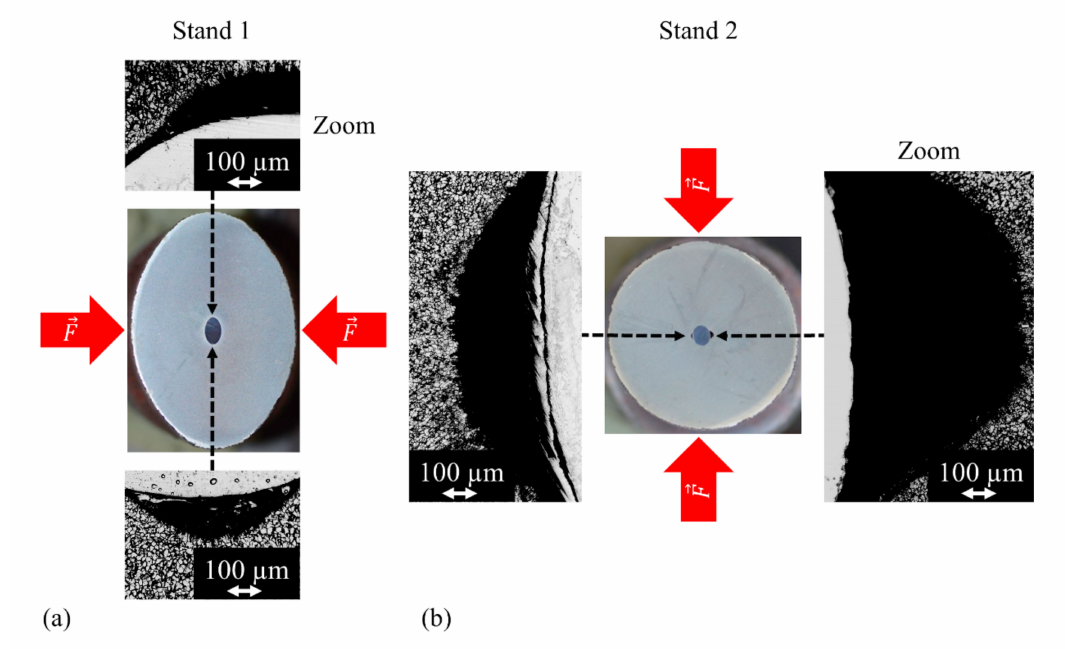
Figure 13. ( a ) Stainless-steel defect morphology after stand 1 of forming and ( b ) after stand 2 of forming ( + 90 ◦ rotation between forming